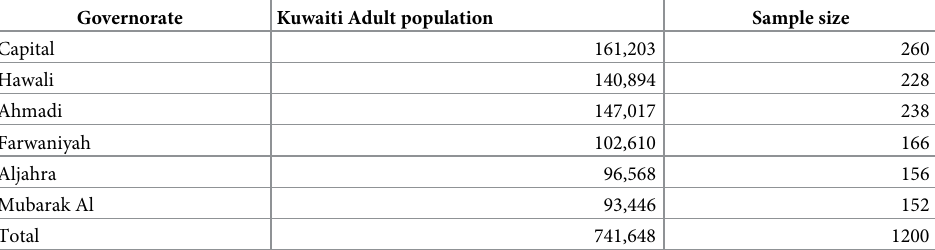
Table 1. Population distribution by Kuwaiti